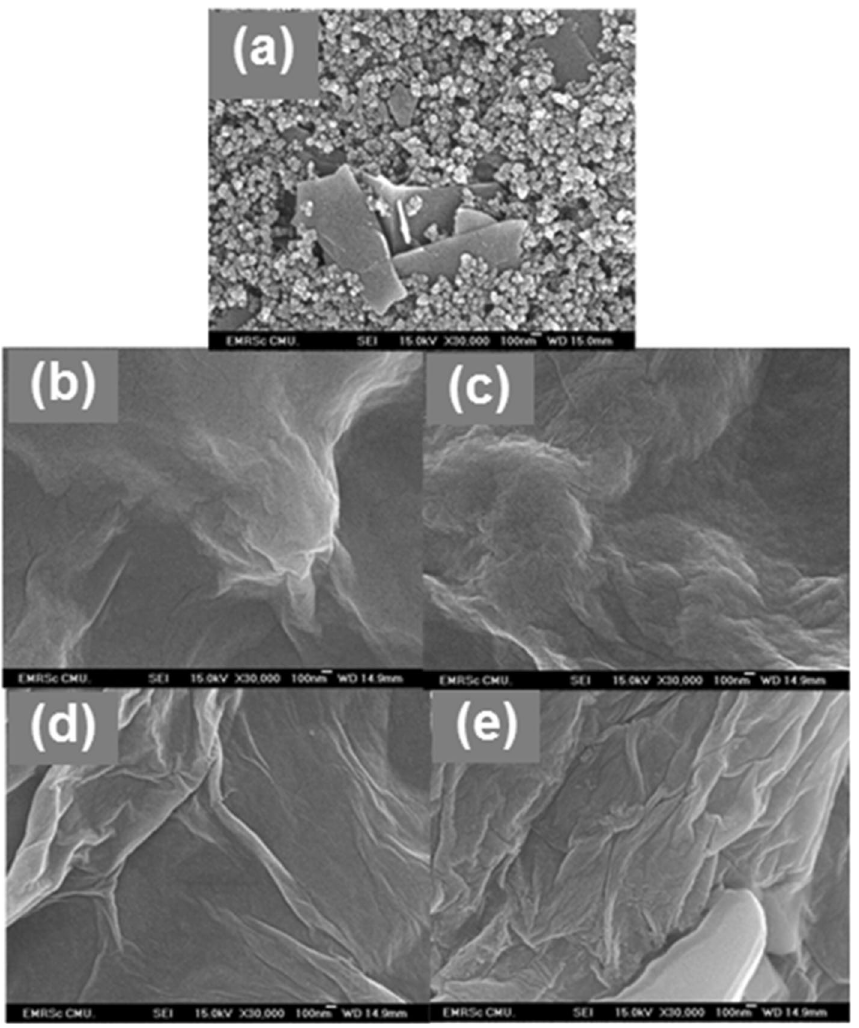
Figure 2. FE-SEM images of bare SPCE ( a ) and GO- ( b ), Cu(II)/GO- ( c ), rGO- ( d ), and Cu(II)/rGO- ( e ) modified